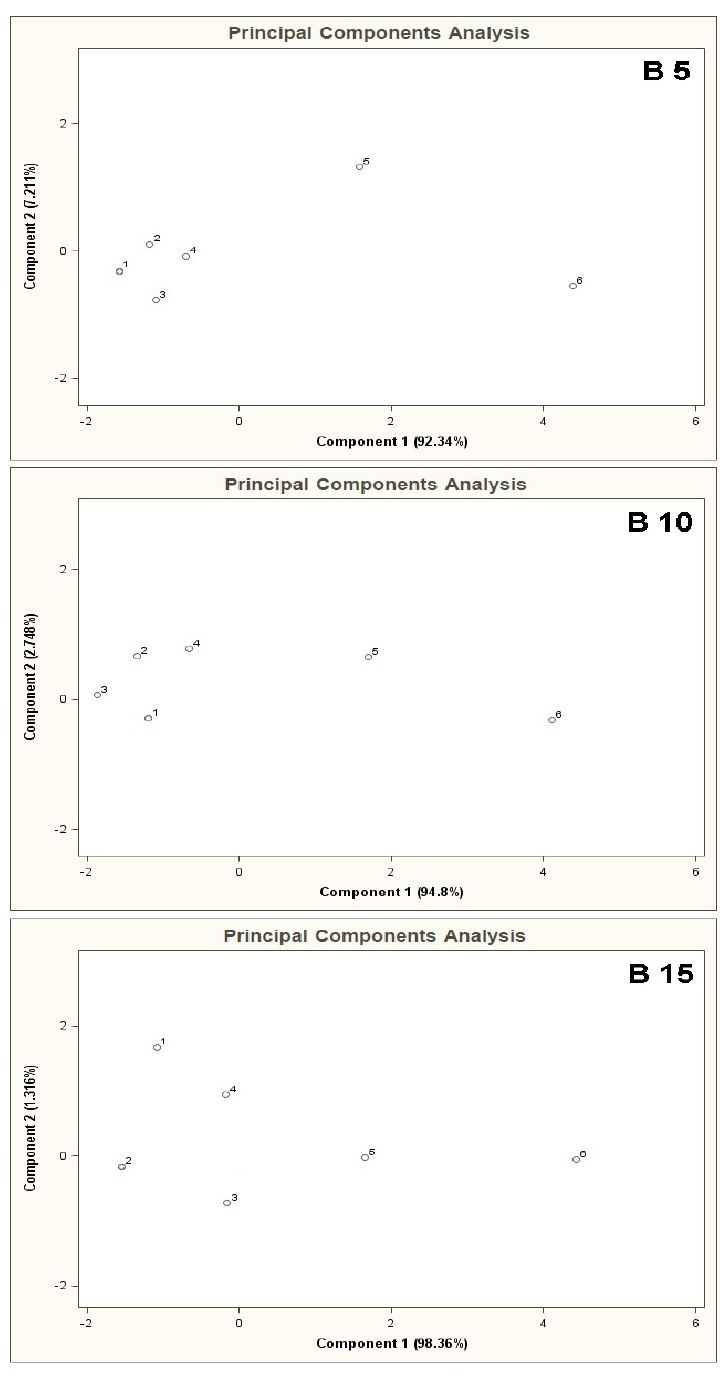
substances with the COPD markers of the respective concentrations: 0 ppb, 5 ppb, 10 ppb, 25 ppb, 50 ppb, 100 ppb v/v. Measurement was obtained for time instant 60